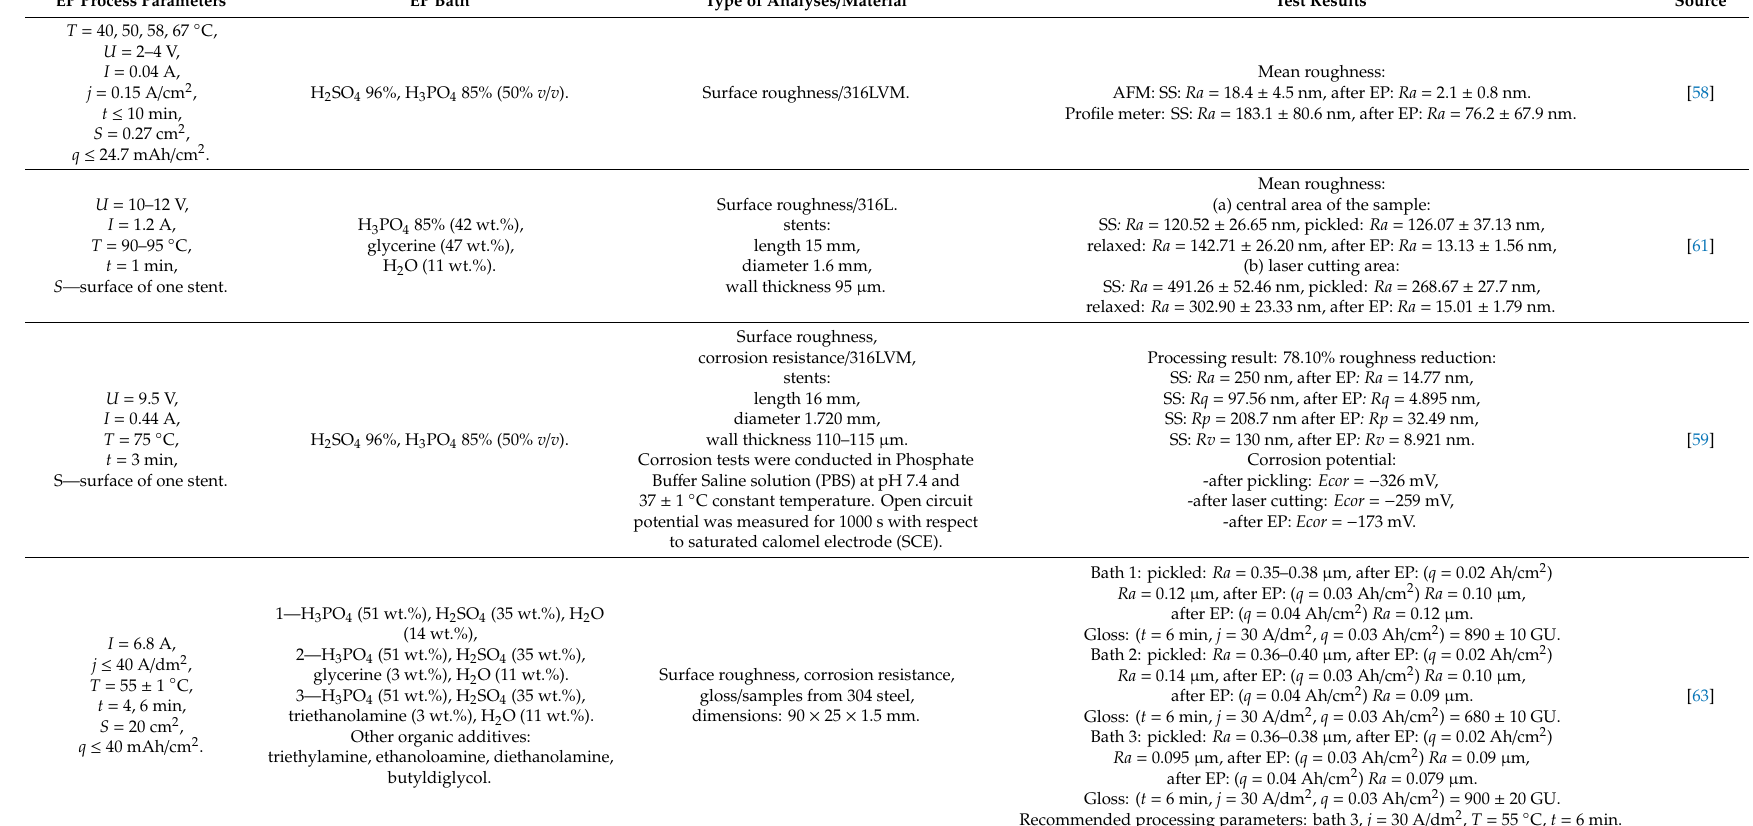
Table 3. Sample parameters of the electrochemical polishing (EP) processes, bath compositions and test